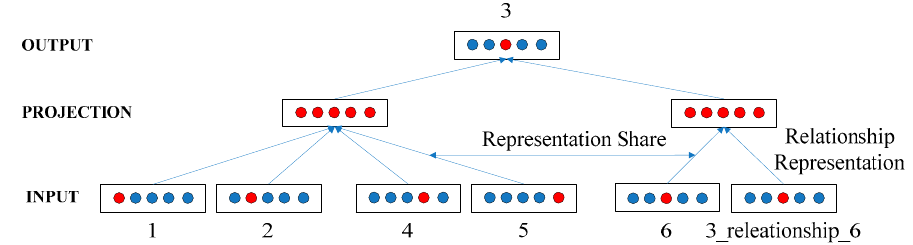
Figure 1. Learning framework of the proposed algorithm in this Figure 1. learning framework of the proposed algorithm in this paper.